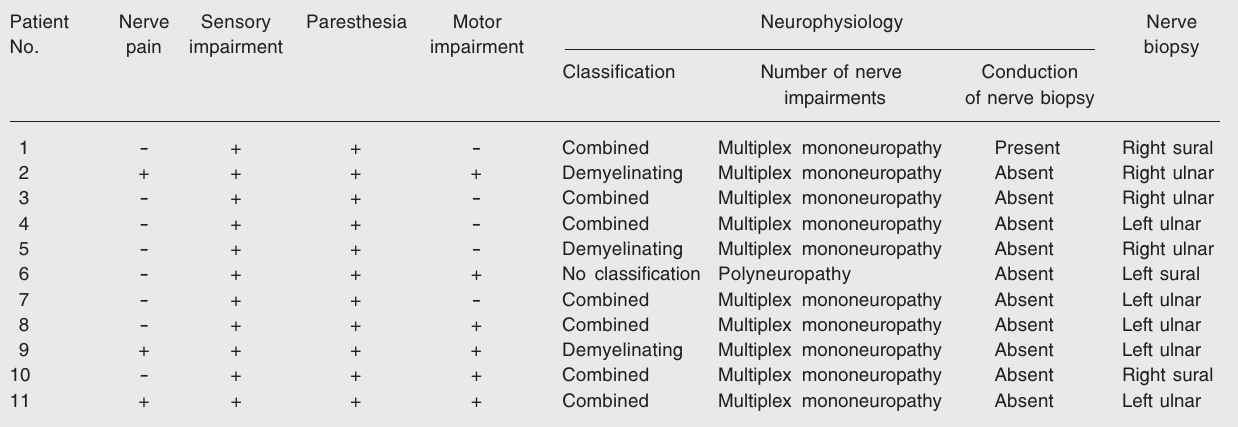
Table 1. Clinical and electroneuromyographic characteristics of the leprosy patients studied.